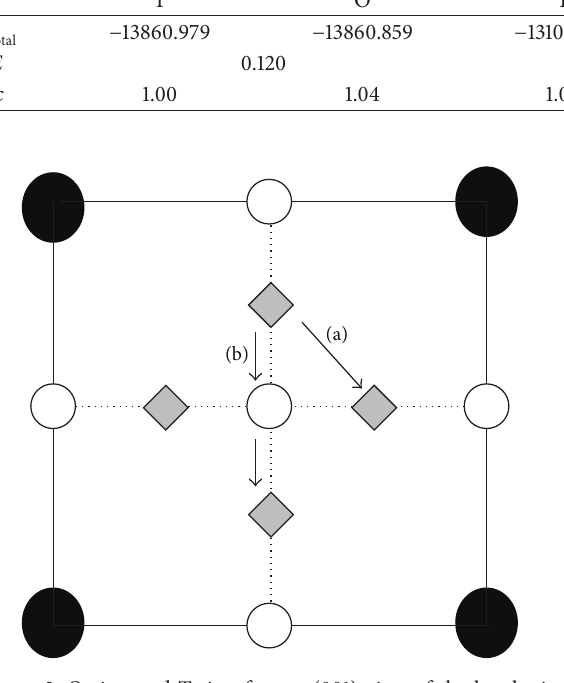
Figure 2: O-sites and T-sites from a (001) view of the bcc lattice, open circles, and diamonds, respectively. Full circles represent Fe atoms.